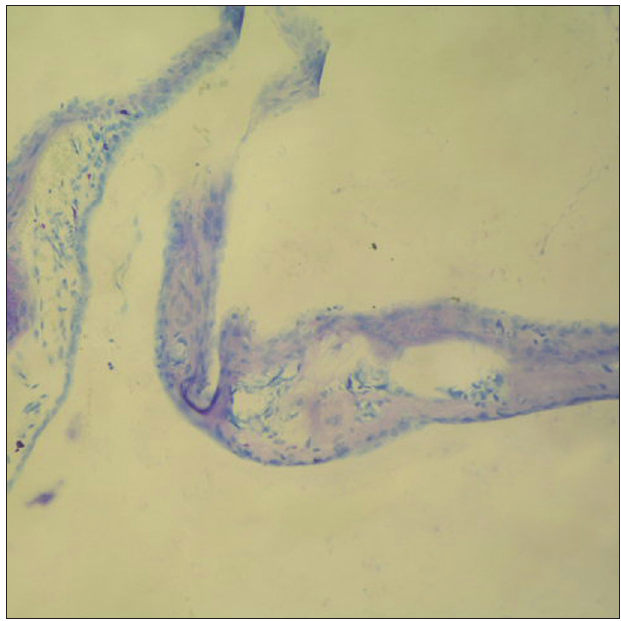
Figure 2. In tympanic membrane evaluated as 4 point scale from group B, the fibroblast proliferation, markedly increased of membra - ne thickness, sclerotic changes are shown (toluidine blue, original magnification x200).